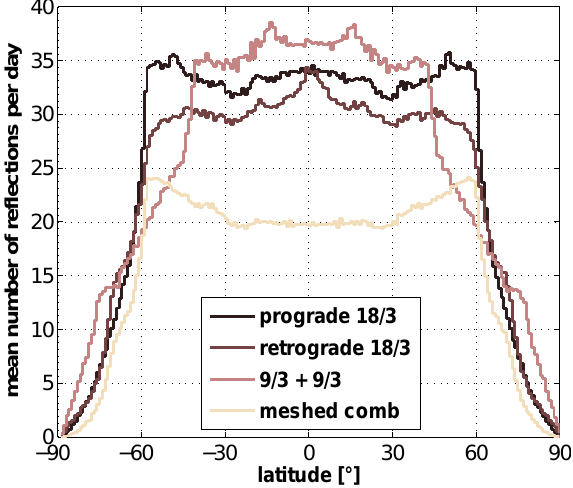
Fig. 3. Latitude distributions of reflection points over one day for different 18 satellite constellations at 900km altitude (Table 1) us- ing GPS as signal source. (a) 18/3 Walker constellation, 60 incli- nation angle, (b) 18/3 Walker constellation, 120 ◦ inclination angle (retrograde), (c) 9/3 Walker constellations with 40 ◦ and 80 ◦ incli- nation angle, (d) meshed comb